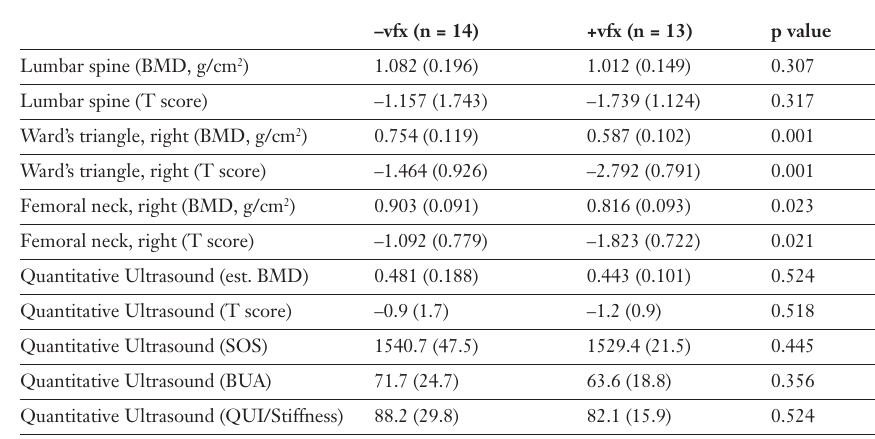
Bone mineral density data.